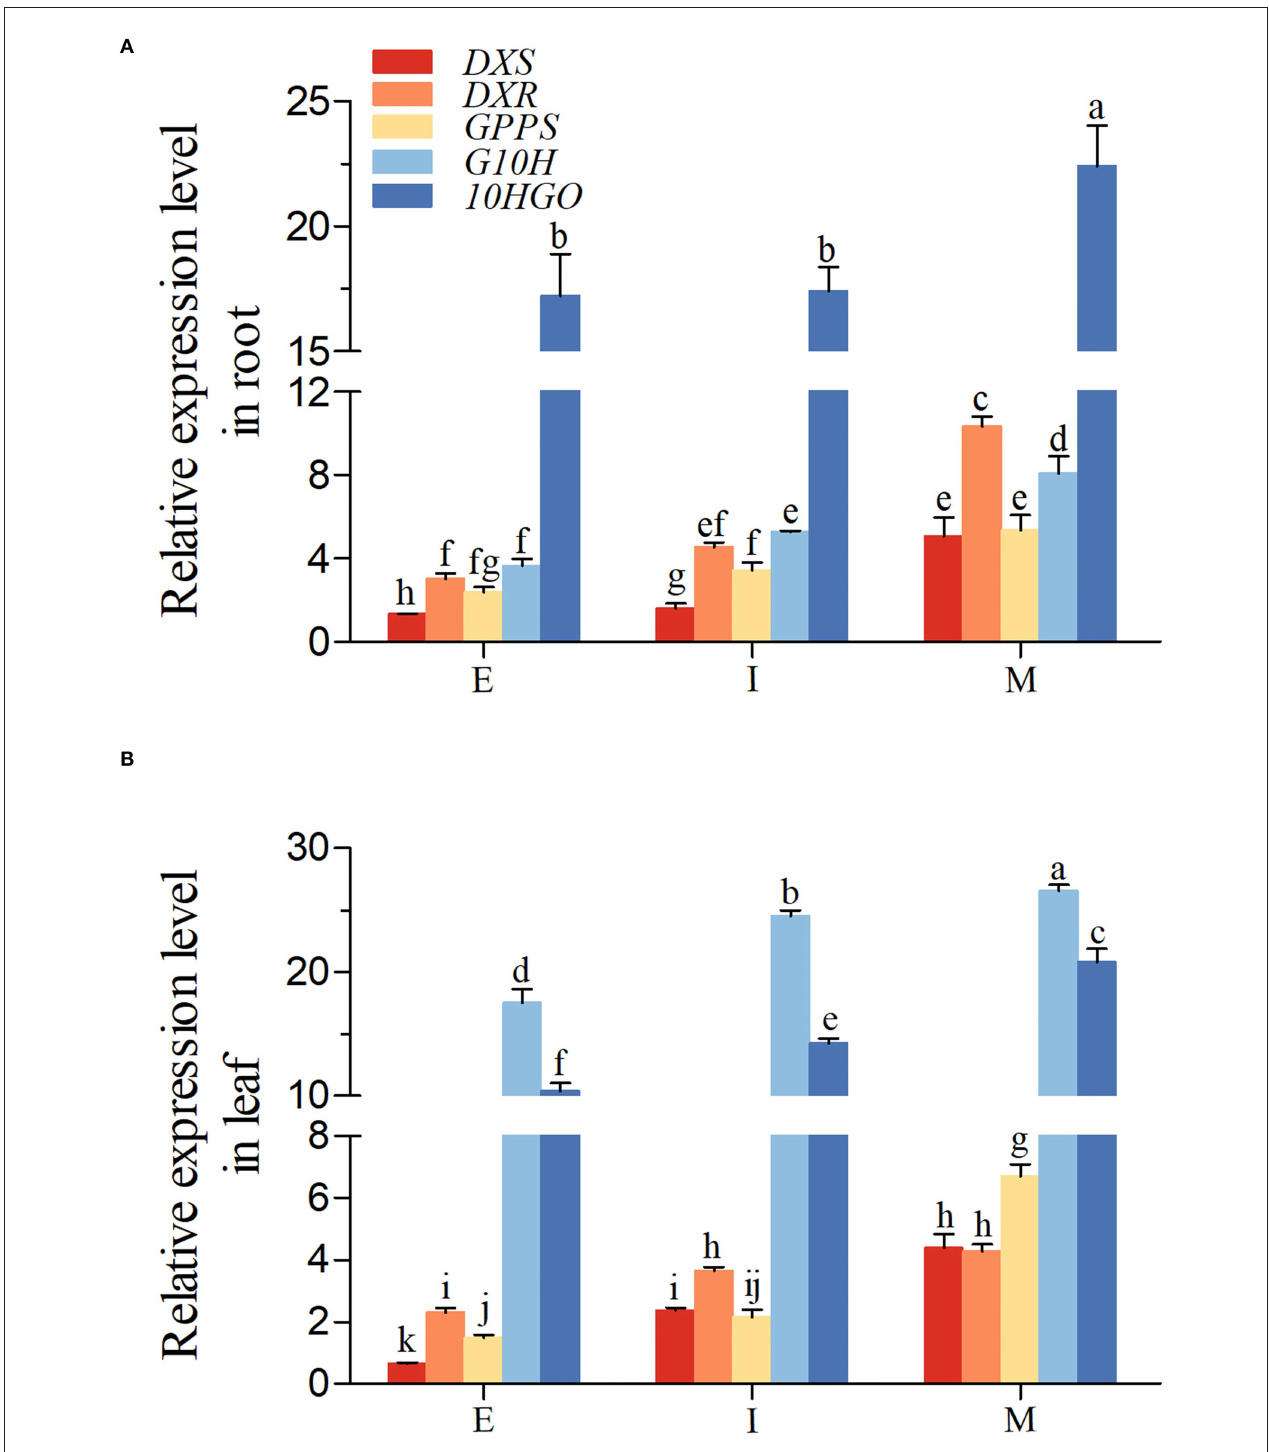
FIGURE 4 | Expression of iridoid glycoside synthetase genes in R. glutinosa. (A,B) respectively, represent the expression of DXS , DXR , GPPS , G10H, and 10HGO in Jinjiu root and Jinjiu leaf of R. glutinosa . E, I, and M represent elongation stage, intumescent stage, or maturation stage of R. glutinosa , separately. The error bar is standard error of mean, and the lower letter above the bar indicates the significant difference among different growth stages of R. glutinosa ( P < 0.05).